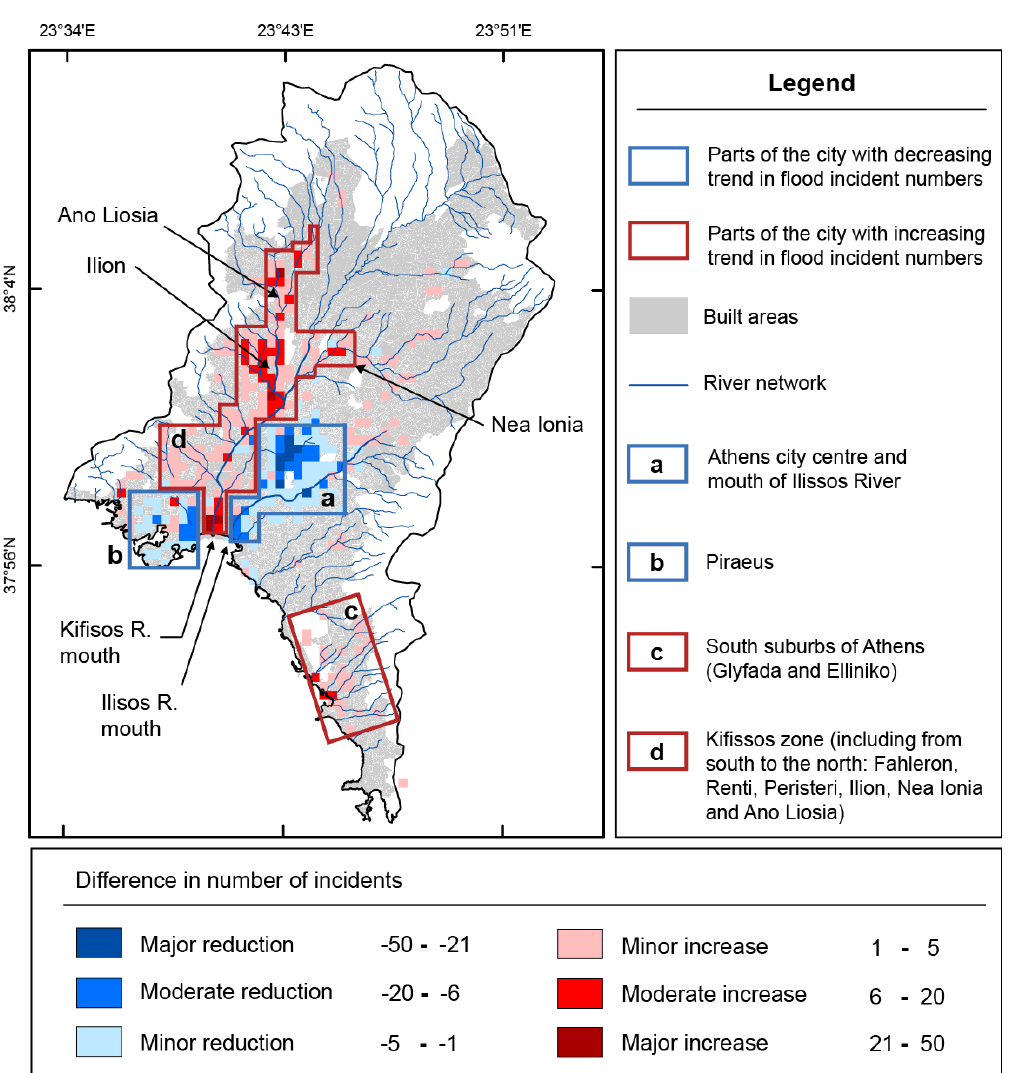
Figure 7. Delineation of parts of the city presenting increasing and decreasing trends in flood-related incident